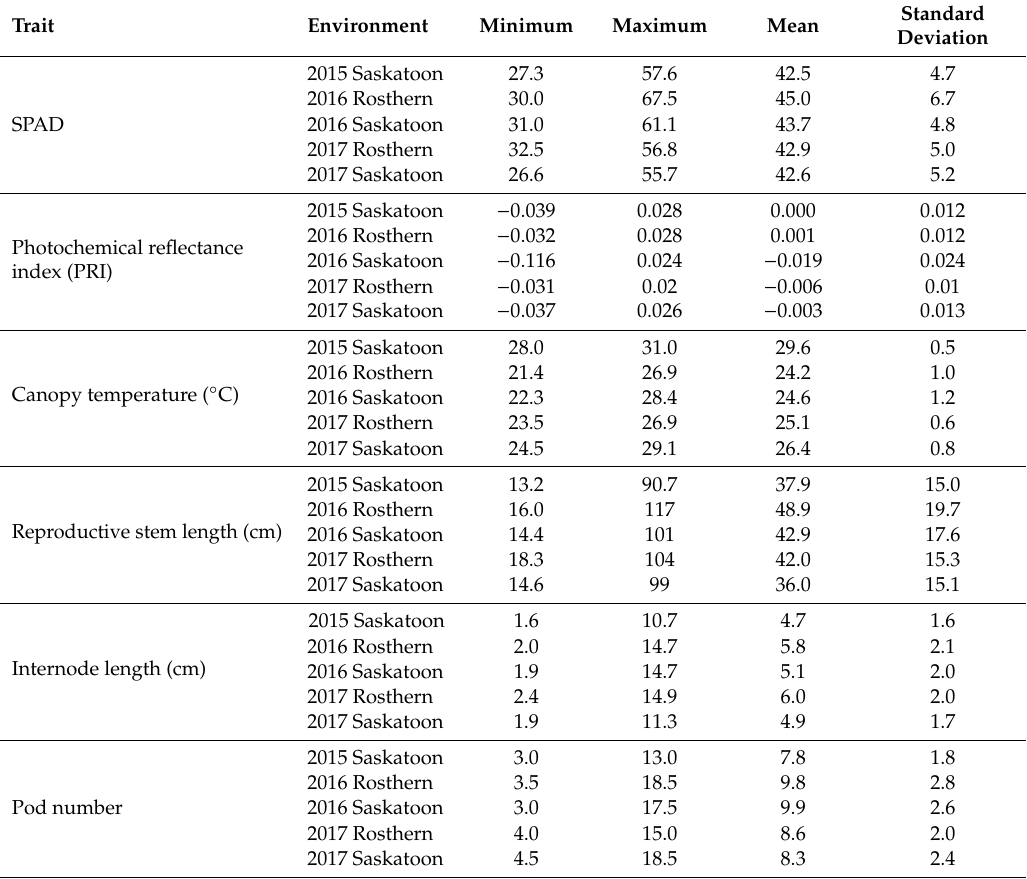
Table 3. Minimum, maximum and mean values of phenotypic traits of 135 pea accessions of the genome-wide association study